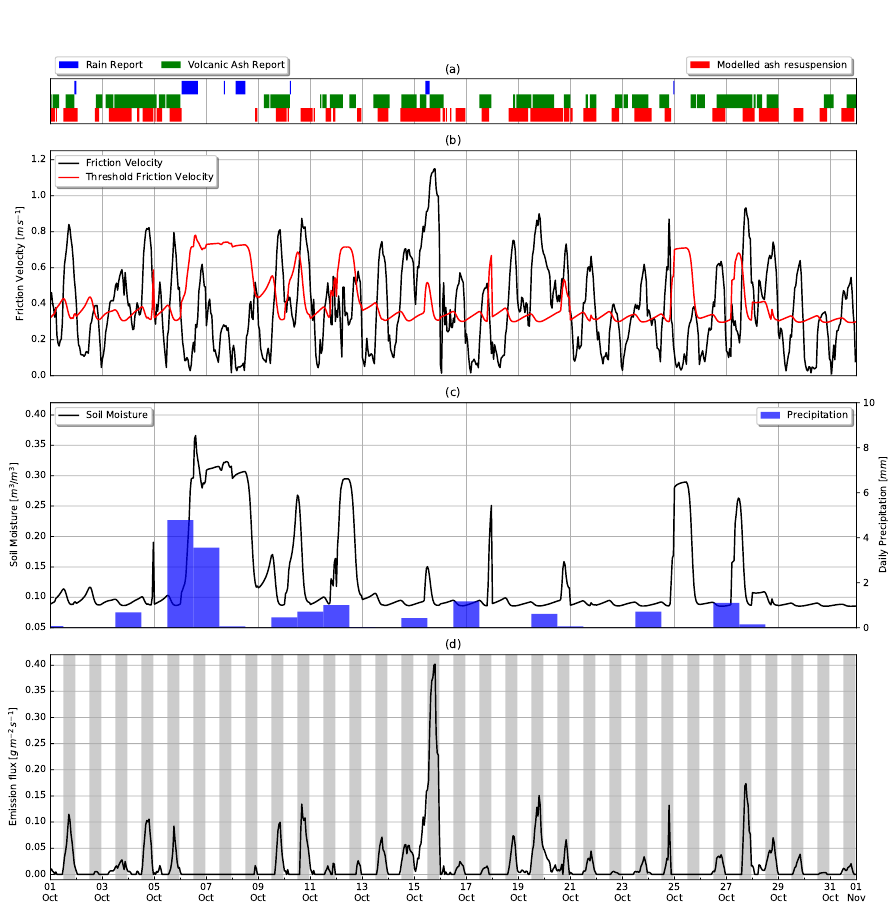
Figure 9. WRF time series and ash-in-suspension reports during October 2011 at Bariloche. ( a ) Reports of rain and ash issued by the Bariloche weather station (blue and green shaded areas, respectively) together with hourly predictions of local ash resuspension (red shaded area) according to the model, that is, u ∗ > u ∗ t . ( b ) Friction velocity and threshold friction velocity. ( c ) Soil moisture and daily precipitation. ( d ) Emission flux given by Equation (5). Shaded areas highlight periods of daylight hours between 12:00 and 23:00 UTC (09:00–20:00 LT), when emission predominantly takes